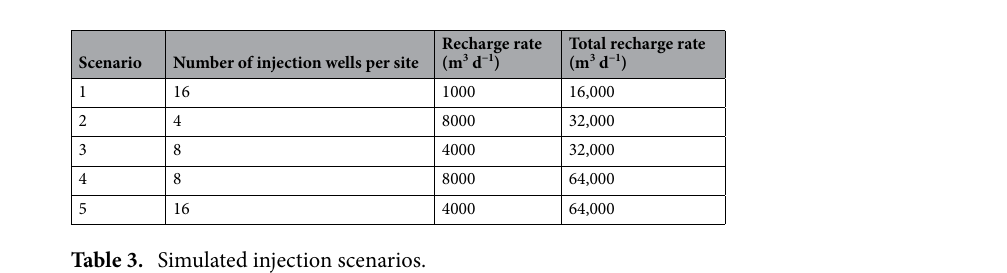
Table 3. Simulated injection scenarios.